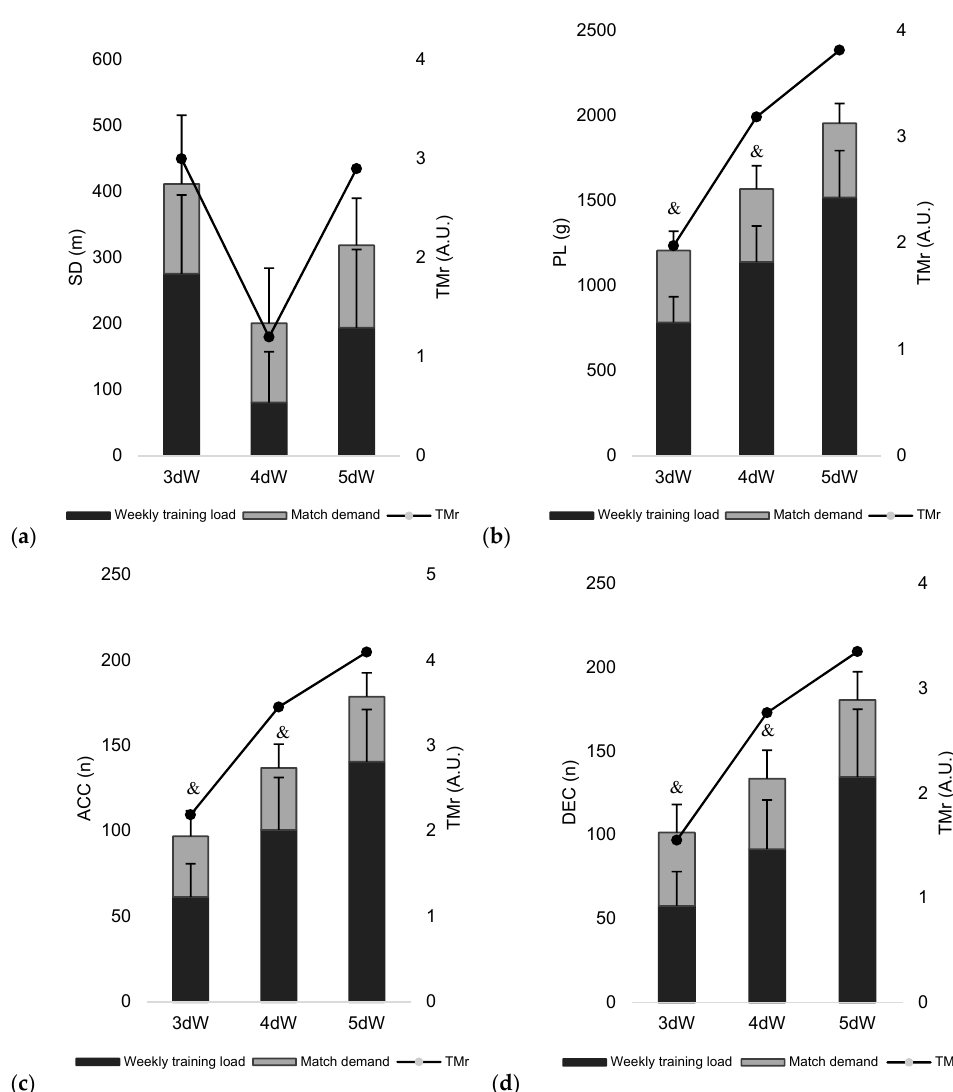
Figure 2. Accumulative weekly ( a ) sprinting distance (SD); ( b ) player load (PL); ( c ) number of accelerations (ACC); ( d ) number of decelerations (DEC) and their training/match ratios (TMr). &: significant different from 5dW.